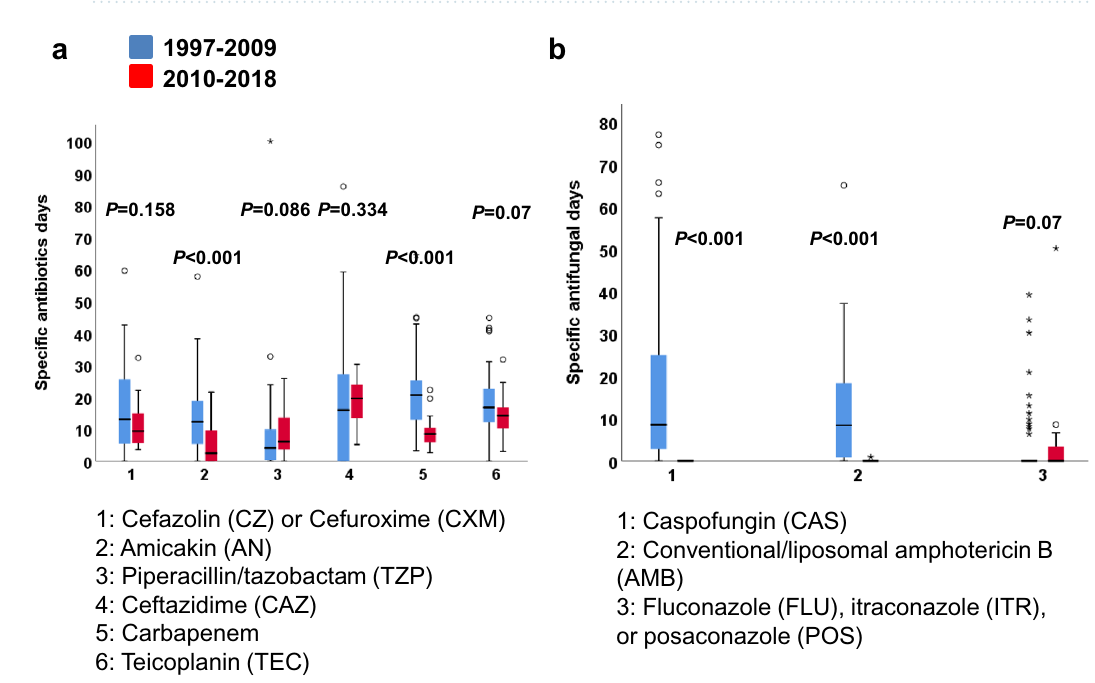
Figure 3. Data of specific antimicrobial days are shown in a box plot; each box plot illustrates the upper and lower quartile (box), median (line inside box), adjacent values (whiskers), and outliers (open circles). Patients receiving antimicrobial prophylaxis had less exposure to carbapenem, amikacin, amphotericin B, or caspofungin when compared with those receiving no prophylaxis ( P < 0.001 , P < 0.001 , P < 0.001, and P < 0.001,